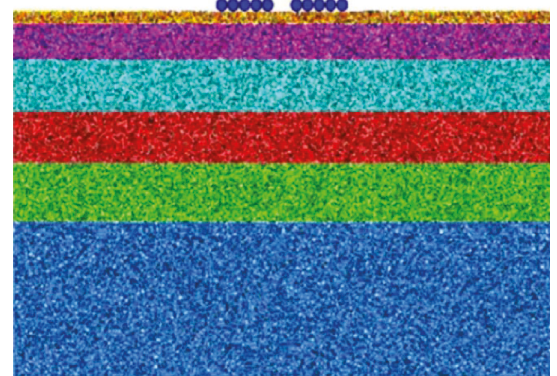
Figure 2: Discrete element model of subgrade and pavement